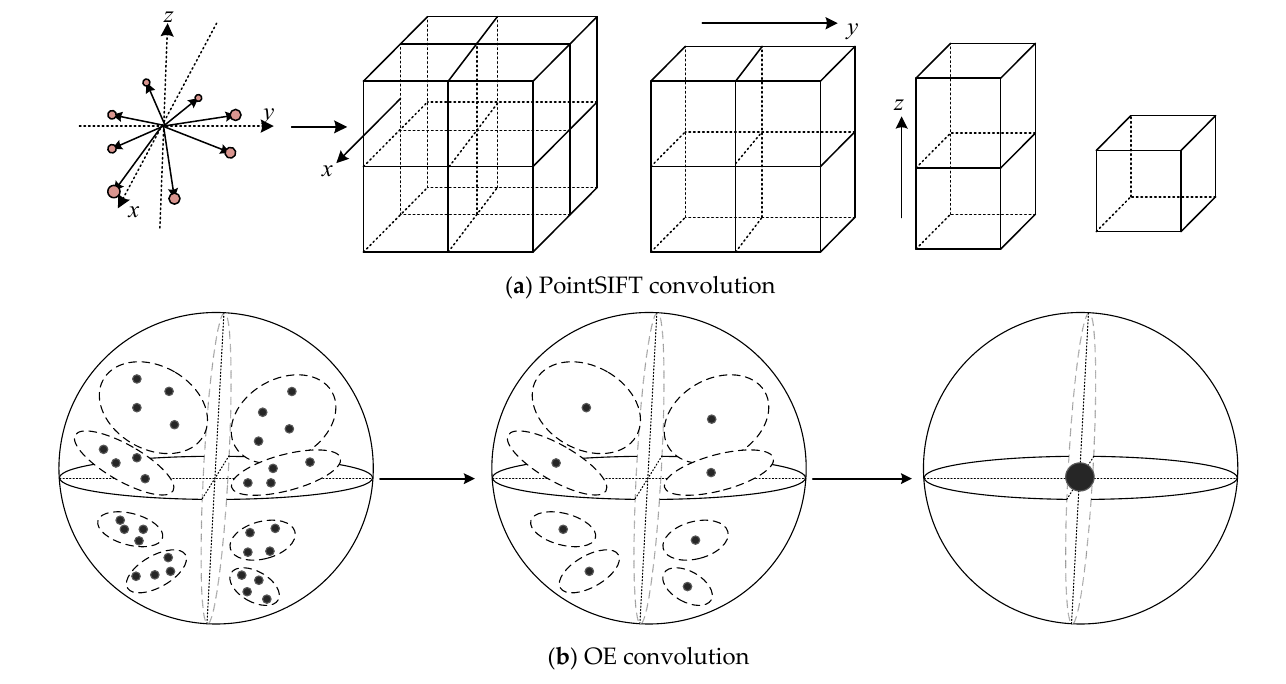
Figure 1. The comparison of PointSIFT and OE convolution.